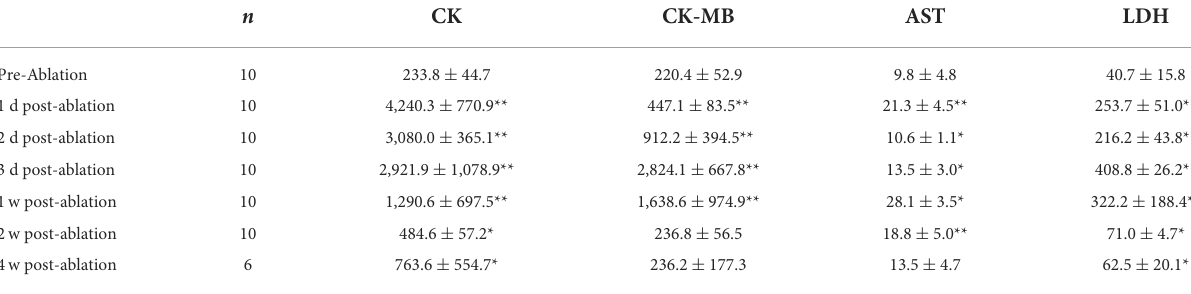
TABLE 1 Myocardial enzyme profile levels at different time points before and after PEF ablation in rabbit hearts. n